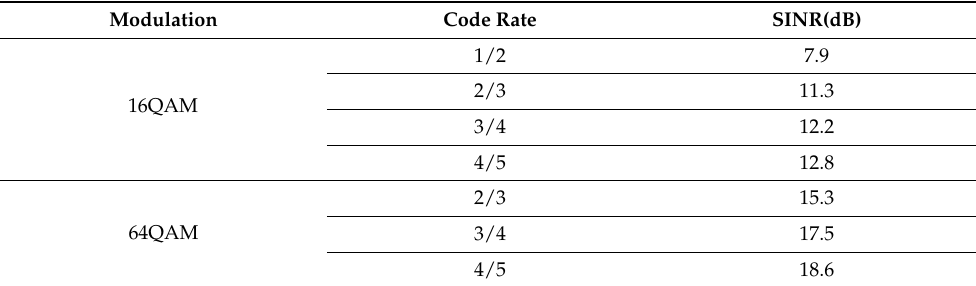
Table 1. MCS and required received Signal-to-Interference-plus-Noise Ratio (SINR).